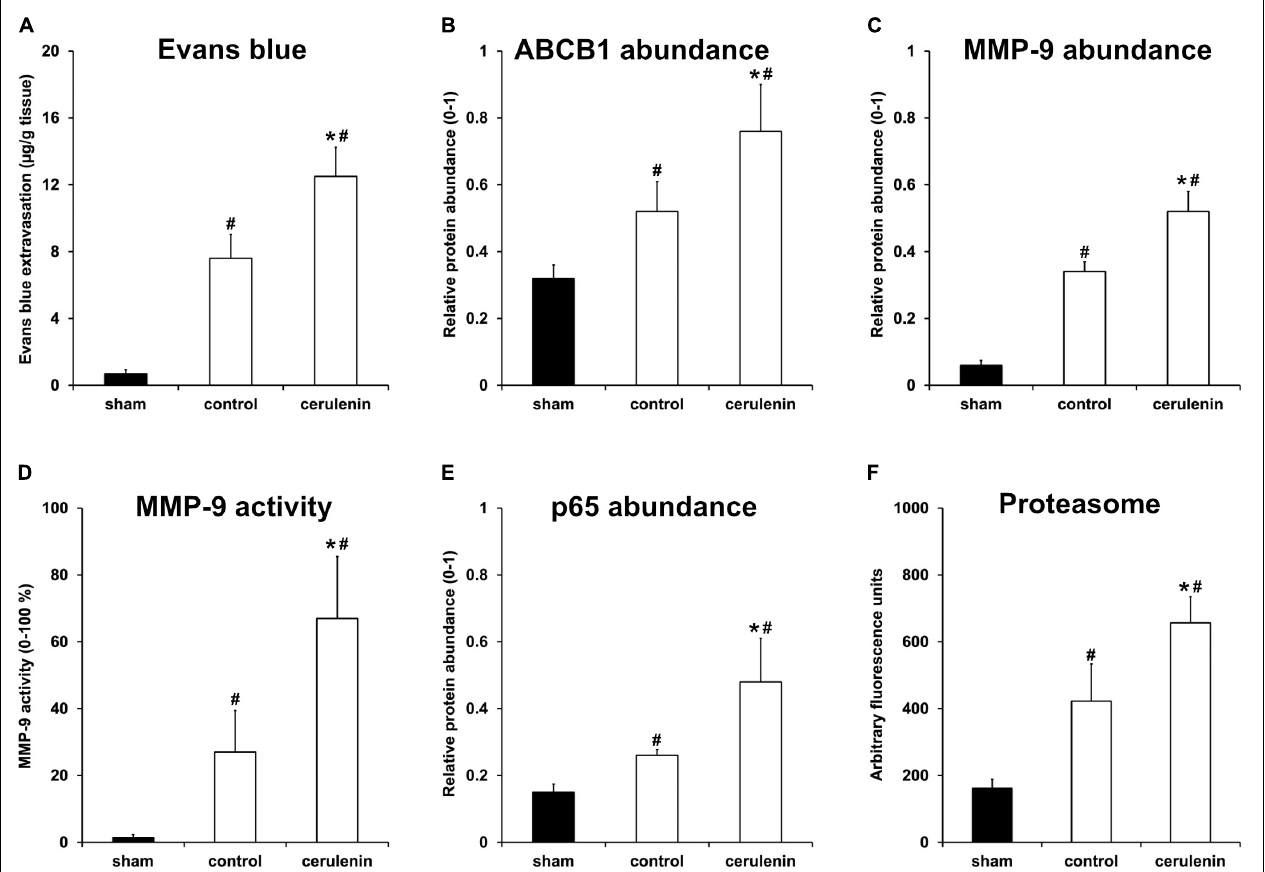
FIGURE 5 | Inhibition of FAS enhances poststroke BBB leakage and stimulates the NF- κ B/proteasome pathway in vivo . All mice ( n = 9 per condition) were exposed to middle cerebral artery occlusion (MCAO) followed by cerulenin treatment or DMSO application (controls). Sham mice underwent the same surgical procedure but without MCAO. End of the experiments was 24 h after induction of MCAO. Blood-brain barrier (BBB) leakage was measured via Evans blue extravasation (A) , whereas ABCB1 (B) and MMP-9 (C) abundance was analyzed by means of Western blotting. MMP-9 activity itself was studied using a gelatin zymography assay (D) . The NF- κ B protein abundance was measured using a Western blot against p65 within the ischemic hemispheres (E) . Proteasomal activity was measured using a fluorimetric assay, as described in section “Materials and Methods” (F) . ∗ Significantly different from controls, p < 0.05. # Significantly different from sham mice, p <